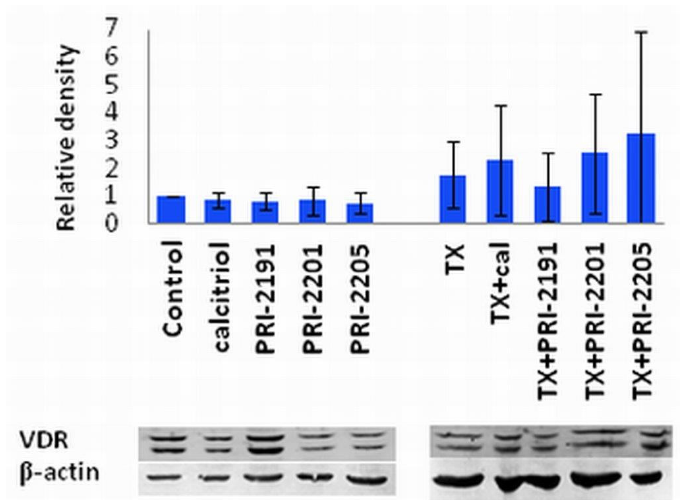
Figure 5. VDR expression in MCF-7 cells treated with TX and vitamin D compounds.The densitometric analysis of the western blots was carried out using ImageJ 1.46r. The blots were normalized to actin and the fold-change protein level expression is reported in comparison to control.